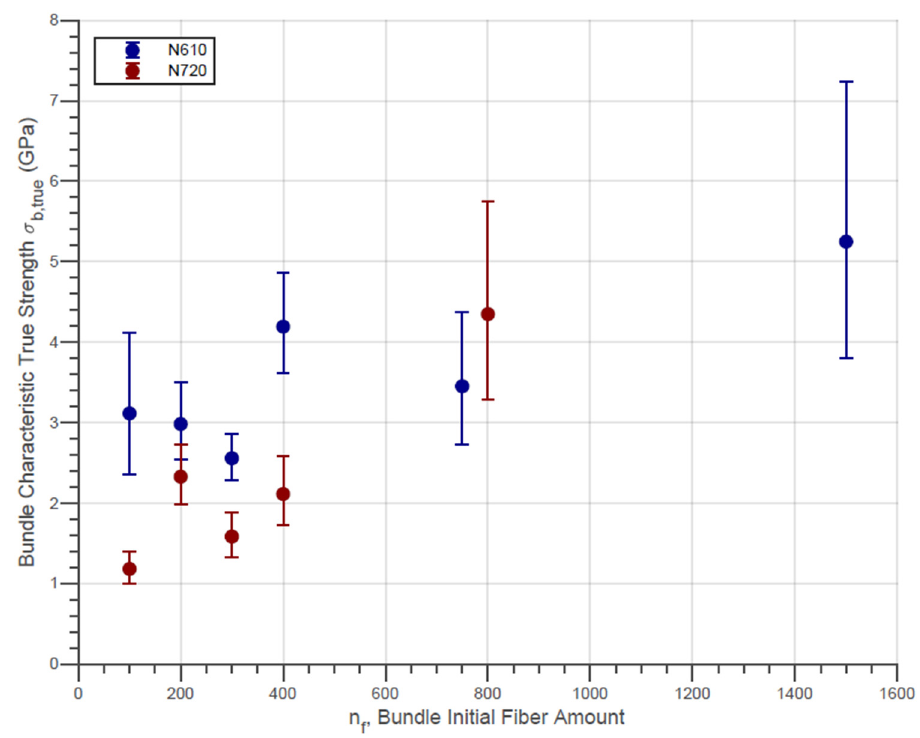
Figure 7. Weibull Characteristic True Strength and Confidence Interval of Fiber Bundles with n f Fibers.